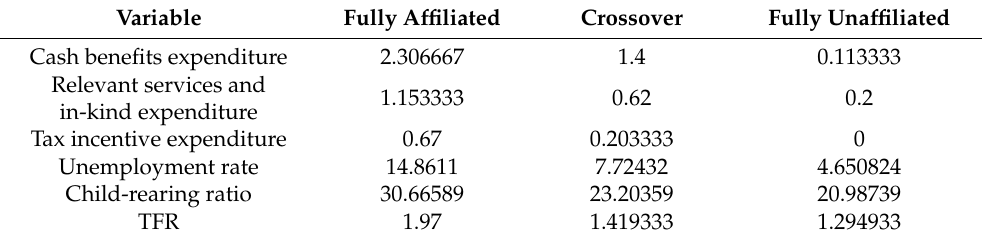
Table 8. Qualitative anchor points for the respective variable.